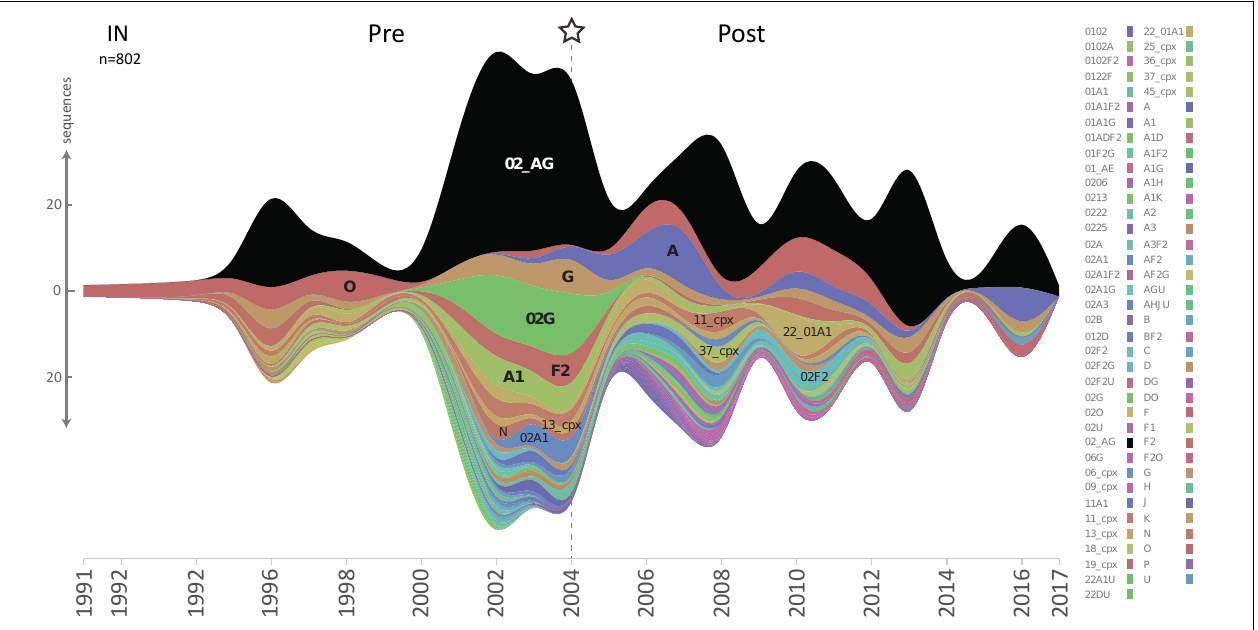
FIGURE 2 | HIV-1 lineage distribution in Cameroon according to HIV-1 pol IN sequences from 1991 until 2020. Stream graph of lineage distribution of Cameroonian HIV-1 pol IN sequences (y-axis). All available IN full-length sequences (HxB2 position bp 4,230–5,093, n = 802) from the LANL database are shown, as of November 3rd, 2020, after excluding non-functional, poor-quality, duplicate, and clonal sequences. HIV-1 subtypes, recombinant forms, and groups are color-coded according to the legend to the right, and the most prevalent lineages are also annotated in the graph. The star and dashed line indicate the year when combinational antiretroviral treatment was implemented in